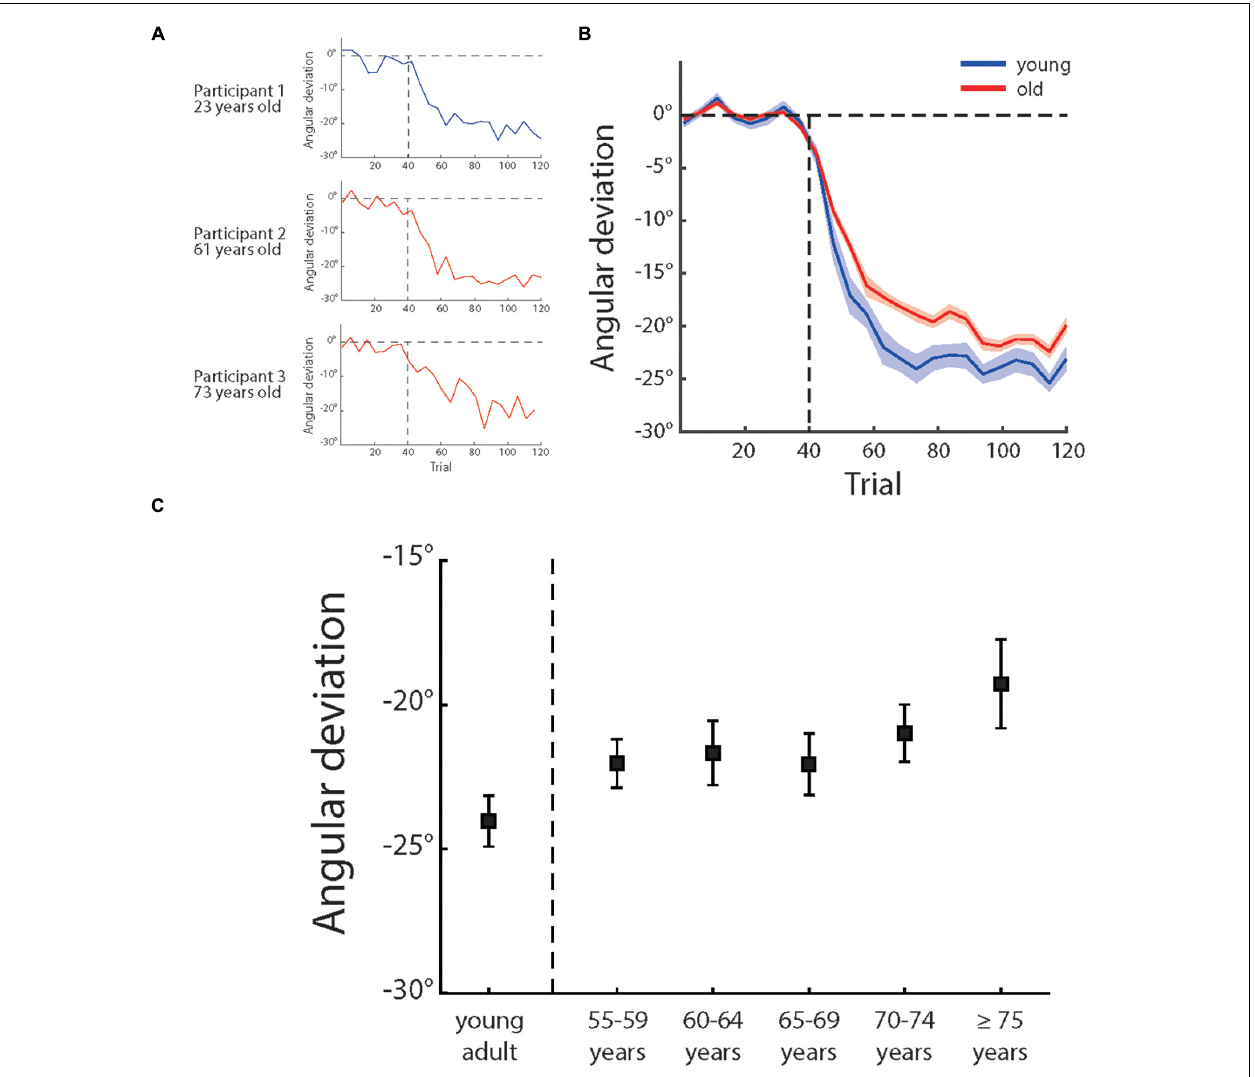
FIGURE 3 | (A) Illustrates the angular deviation as a function of trial number of three sample participants of different age groups and (B) illustrates the mean angular deviation as a function of trial number of young adults (blue) and older people (red). The shadow areas depict ± 1 standard errors, (C) illustrates the mean angular deviation of last 15 adaptation trials of different age groups (for each group, n = 20). The error bars depict ± 1 standard